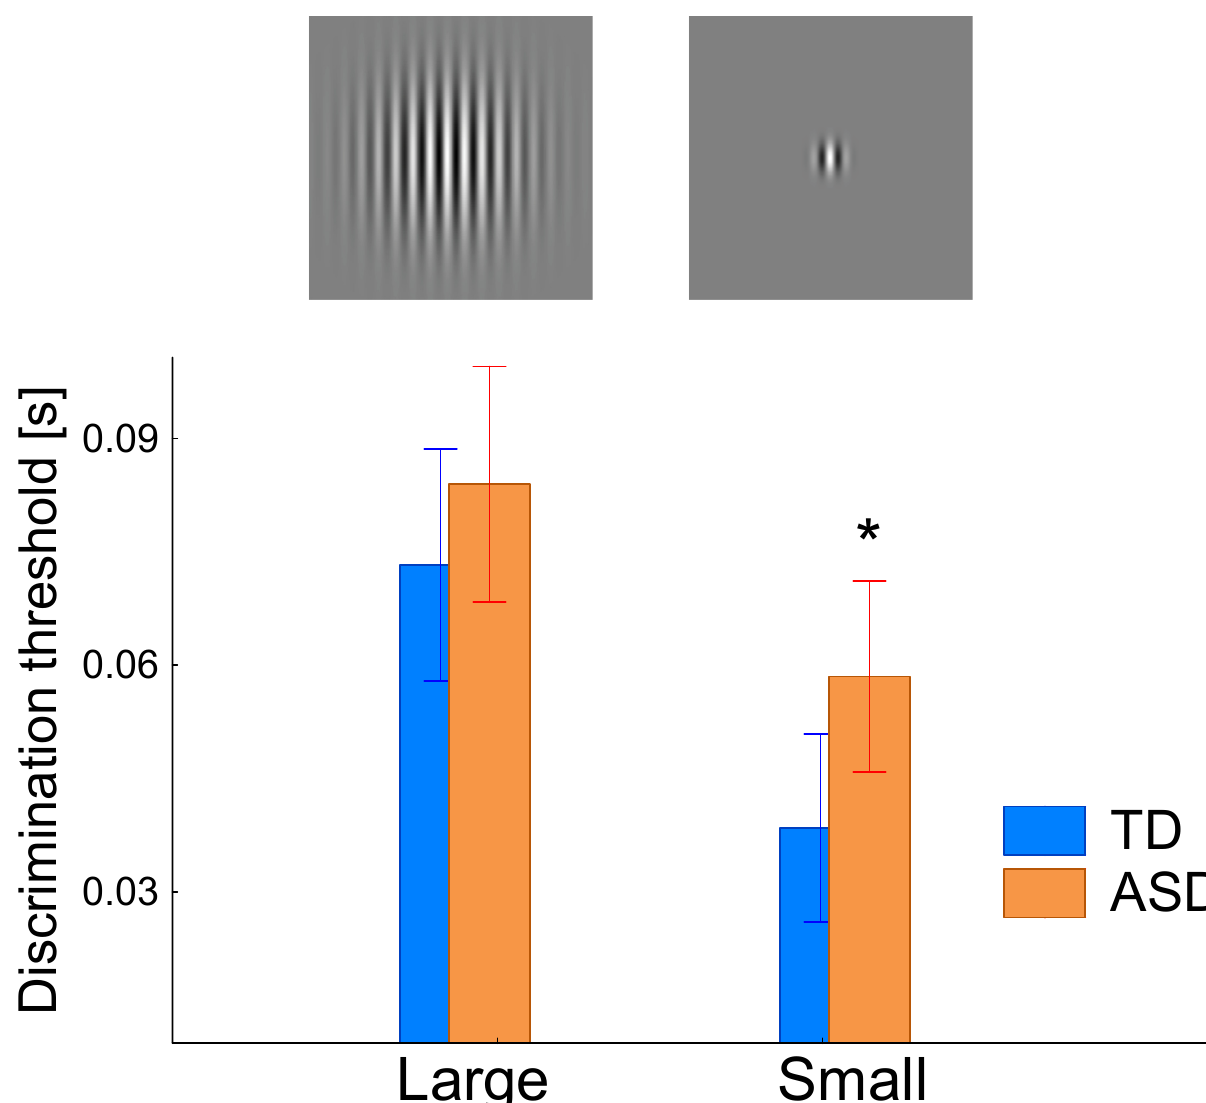
Fig 7. Motion direction discrimination thresholds for the small and large gratings in children with TD and ASD. � Between-group difference: p = 0.02.